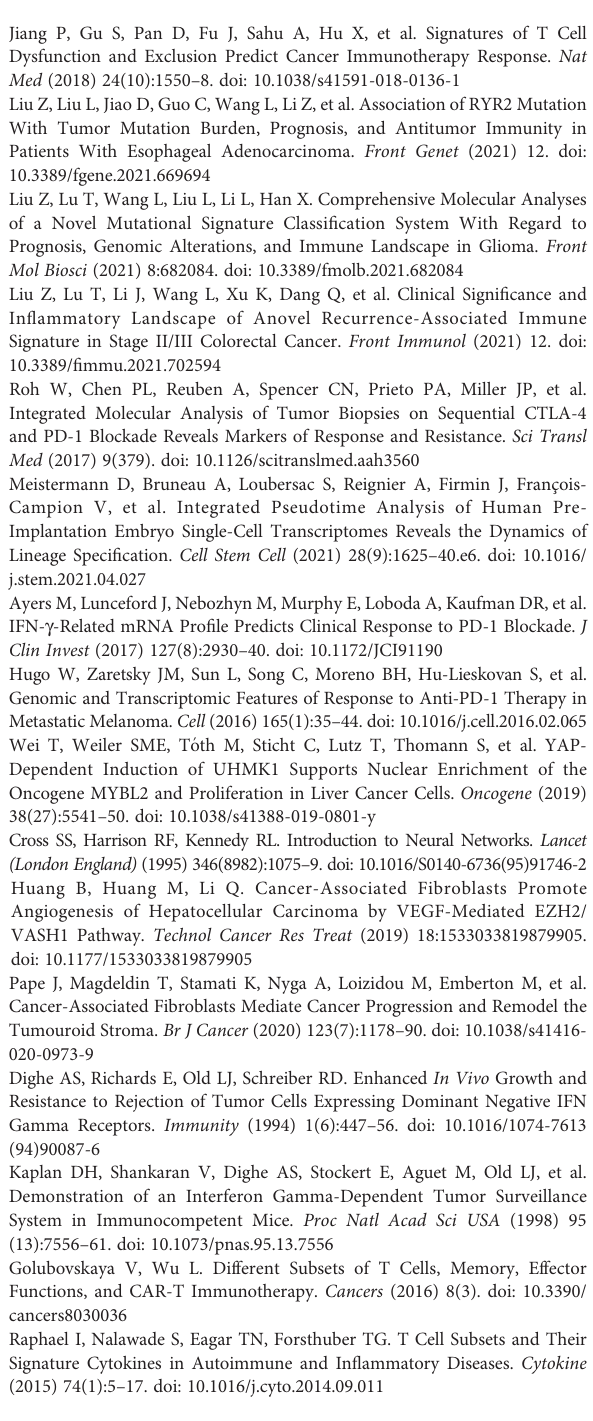
Supplementary Figure 4 | Validation of the sensitivity of the chemotherapeutic drugs and immune response. (A) The estimated IC50 of four common chemotherapeutic drugs in high and low CAS samples in the ICGC dataset. (B) The estimated IC50 of four common chemotherapeutic drugs in high and low